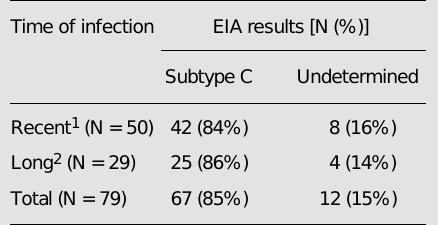
Table 5. V3 serology in samples typed as subtype C by HMA in samples from Zimbabwe and India. Time of